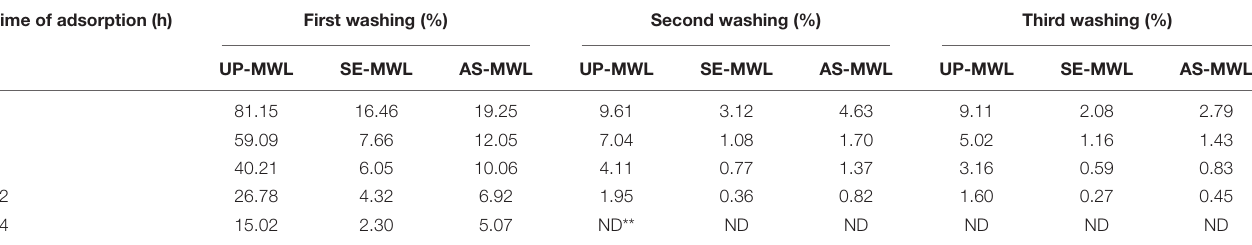
FIGURE 5 | Adsorption isotherm model of Langmuir (A,D,G) , Hill (B,E,H) , and Dubinin–Radushkevich (C,F,I) for the adsorption of Xyn10A onto lignin isolated from AS- and SE-pretreated corn stover and unpretreated corn stover. AS, ammonium sulfite; SE, steam explosion. TABLE 4 | The elution rate* of protein adsorbed in the lignin after different washing of lignin–Xyn10A complex by buffer. Time of adsorption (h) First washing (%) Second washing